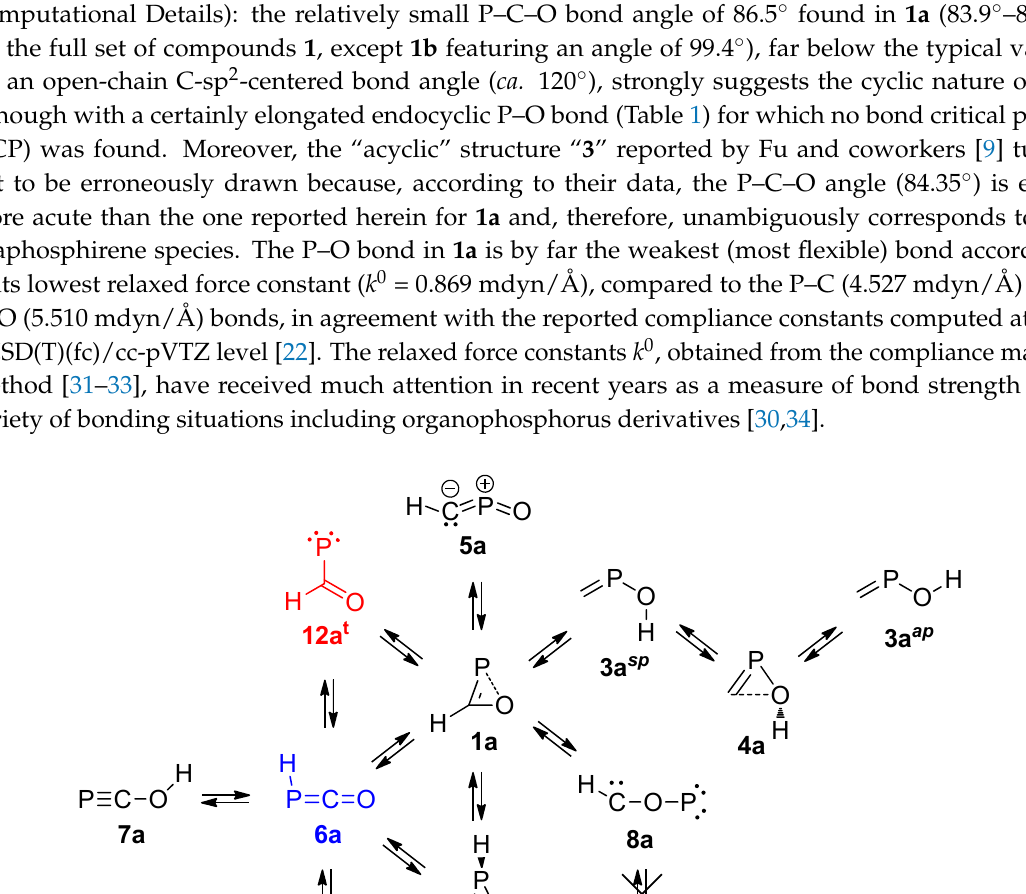
Table 1. Endocyclic bond strength parameters and natural charges.